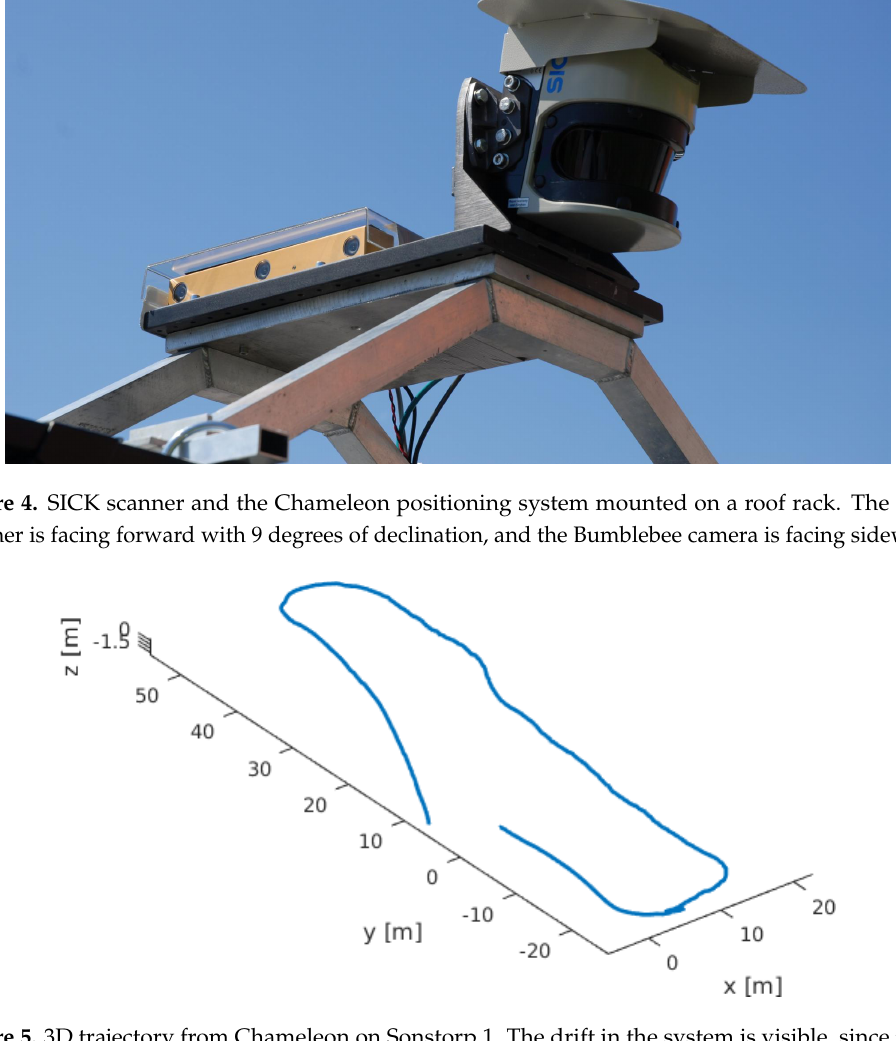
Figure 5. 3D trajectory from Chameleon on Sonstorp 1. The drift in the system is visible, since these data were recorded from a closed